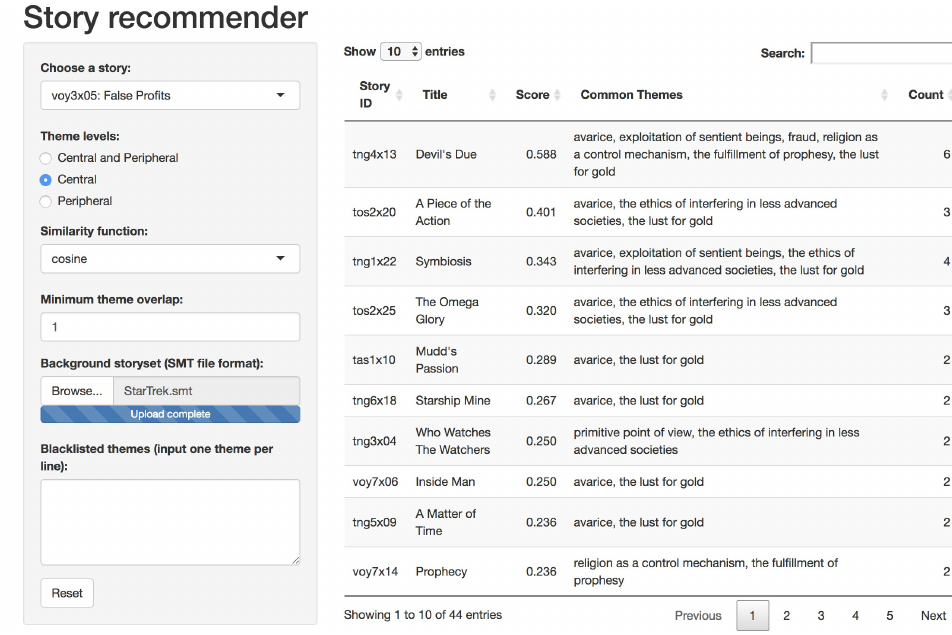
Figure A1. Story recommender R Shiny web application screenshot. The table lists the top ten most similar episodes to the Voyager episode False Profits. Pairwise episode similarity is determined by applying the cosine index to central themes. The file StarTrek.smt is a background storyset file containing story IDs for all 452 thematically annotated Star Trek television series episodes considered in this